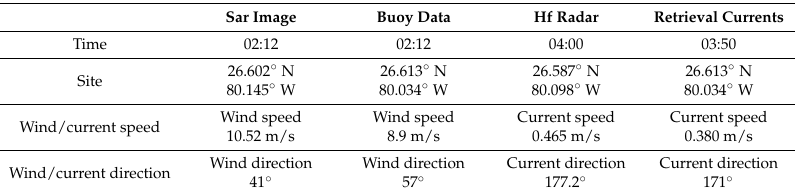
Figure 8. Retrieved-ocean current ( left ) and directions ( right , blue vectors are retrieved-ocean directions and red vectors are measured by HF radar) distribution map. Units are centimeters per second, and degrees, respectively. The ocean current speed is 46.5 cm/s and the corresponding current direction is 177.2° at buoy #LKWF1. Table 2. Winds retrieved from fully polarimetric SAR images and NDBC buoy ##LKWF1, ocean surface currents measured by HF radar and retrieved ocean currents. Parameters of four kinds of data are simultaneous and collocated. Data are received on 19 January 2013.